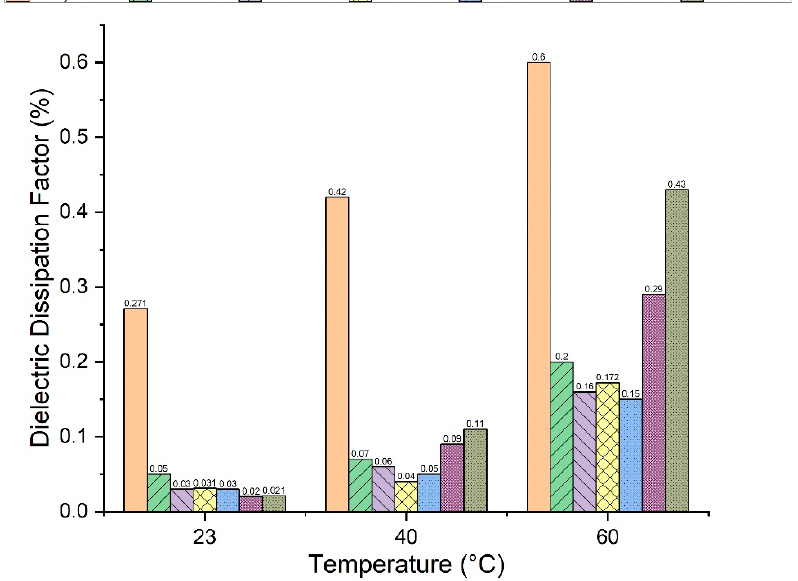
Figure 8. The DDF Vs. Temperature plot of nanofluids and pure oil.